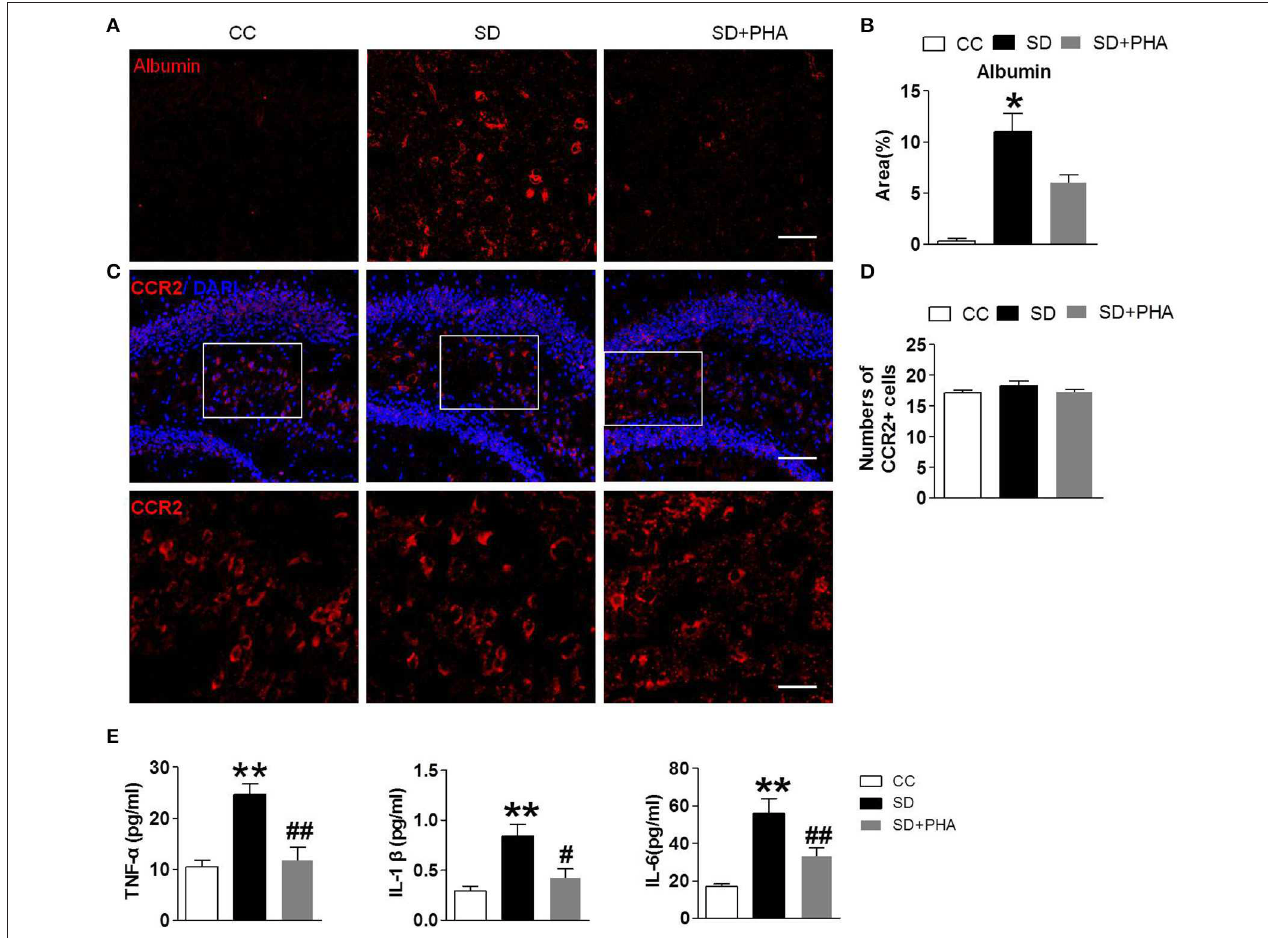
FIGURE 5 | Sleep deprivation mediates peripheral inflammatory, BBB disruption and no more macrophages infiltration in hippocampus. Imfluorescence micrographs of brain cryosections showing the distribution of albumin and macrophages in the hippocampus of mice. Red labeling represents albumin extravasation as a marker of BBB damage and the CCR2 as a marker of macrophages. (A,B) Compared to control group, sleep deprivation increased the expression of albumin in the hippocampus. After PHA-543613 treatment, the albumin deposition in hippocampus was decreased compared to the sleep deprivation. (C,D) Conversely, there were no more macrophages in the hippocampus after sleep deprivation than control group. (E) The release of peripheral inflammatory factor TNF- α , IL-1 β , IL-6 was increased after sleep deprivation, activation of the α -nAChR by PHA-543613 reduced the release of TNF- α , IL-1 β , IL-6. Data are expressed as means ± SEM. * P < 0.05, ** P < 0.01, vs. control group, # P < 0.05, ## P < 0.01, vs. SD + PHA-543613